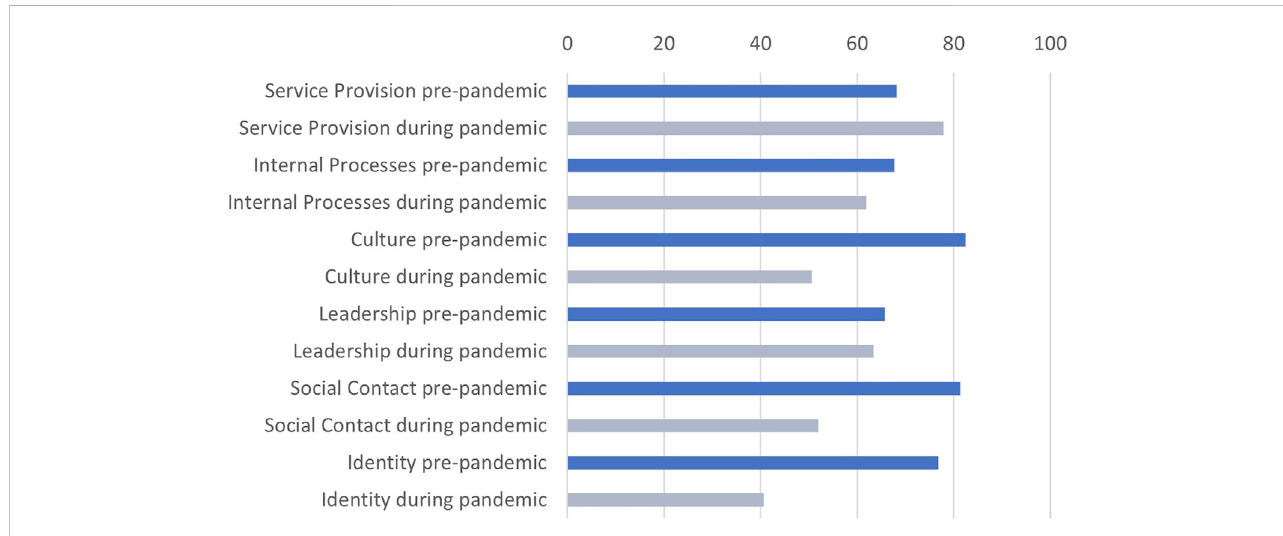
FIGURE 1 Mean values of focus group participants ’ summative quantitative assessments of the topics ( n = 17; 0 = low/dissatisfactory, 100 =